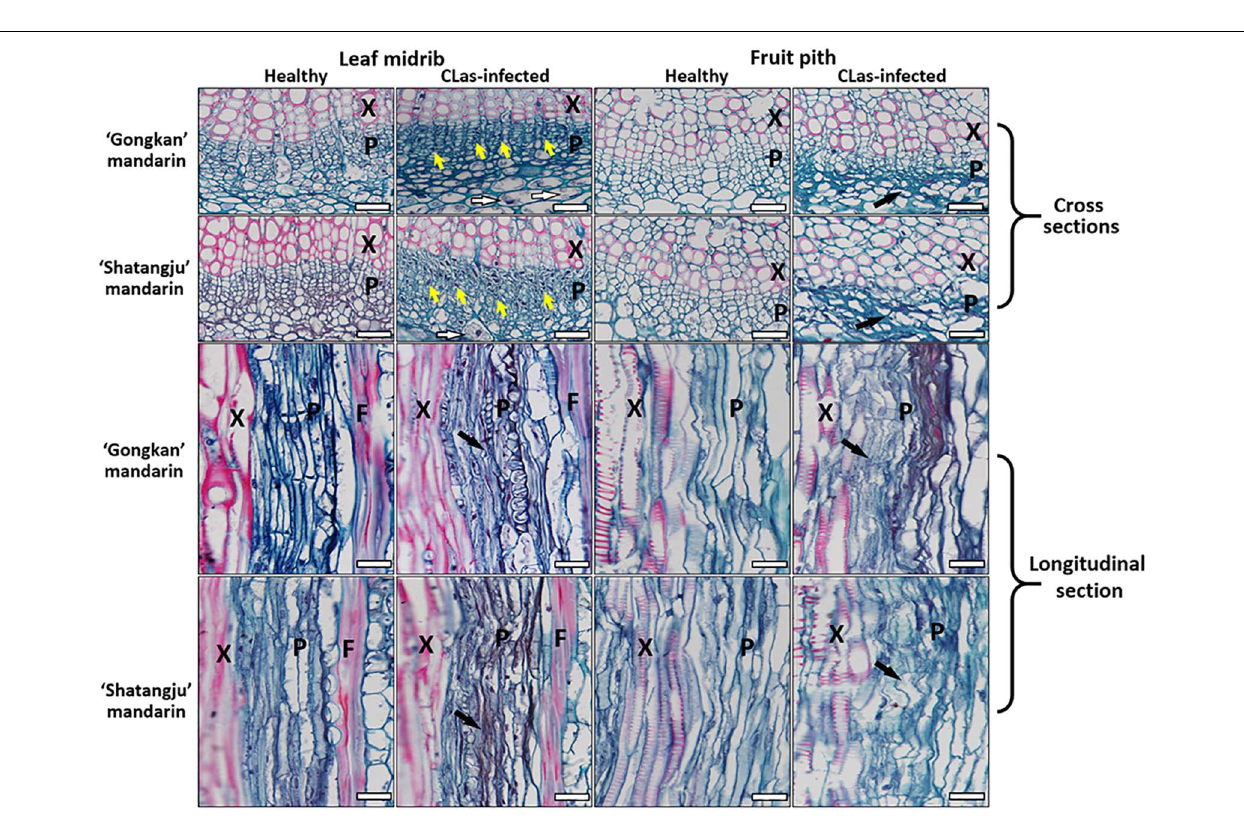
FIGURE 7 | Light micrographs of leaf midribs and fruit pith from “ Candidatus Liberibacter asiaticus”–infected and healthy “Gongkan” and “Shatangju” mandarin. X, xylem; F, fiber; P, phloem. The callose plugs (yellow arrow), collapsed phloem (black arrow), and starch granule accumulation (white arrow) are commonly observed in CLas-infected lead midrib. Bar = 30 µ